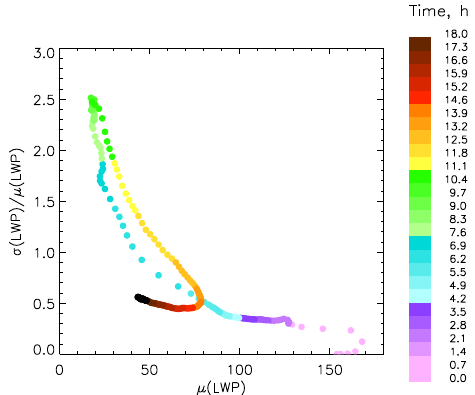
Figure 15. Phase diagram for the relative dispersion of LWP (σ( LWP )/µ( LWP )) vs. the mean LWP (µ( LWP )) for the sim- ulation in Fig. 7. Colors indicate simulation time. Note that the re- covery from open- to closed-cell state is characterized by higher σ/µ for given µ